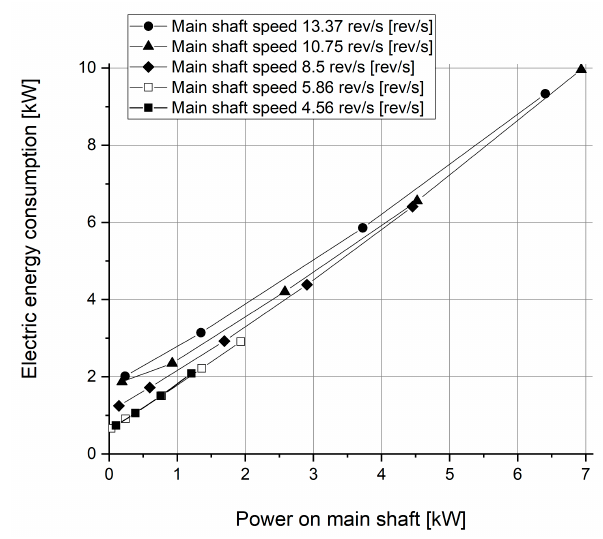
Figure 8. The measured energy consumption as a function of the main shaft speed during the operation of the propulsion in electric engine mode.